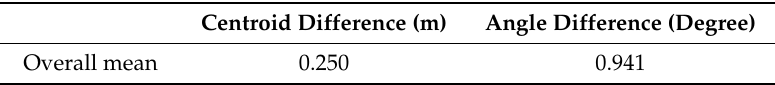
Table 14. Overall mean values of centroid difference and angle difference measures (Adaptive cylindrical